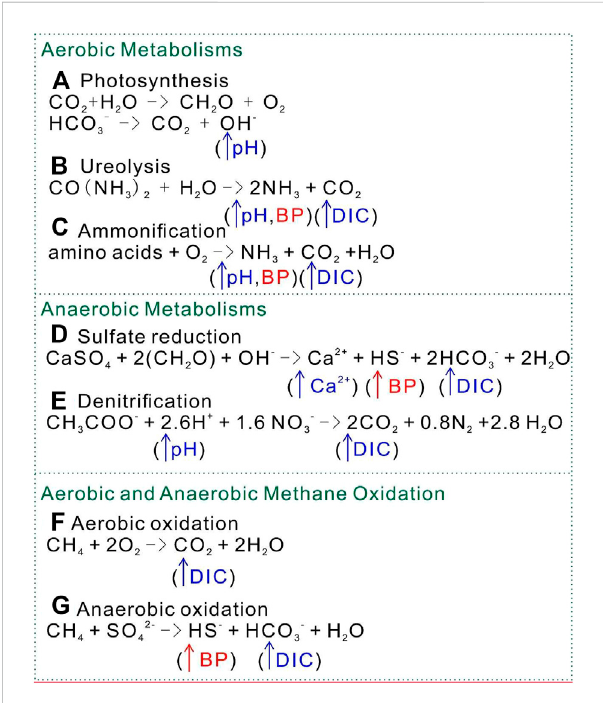
FIGURE 1 Factors that induce carbonate precipitation by different metabolisms. BP, byproduct; DIC, dissolved inorganic carbon. (A) Photosynthesis: (B) Ureolysis; (C) Ammoni fi cation; (D) Sulfate reduction; (E) Denitri fi cation; (F) Aerobic methane oxidation; (G) Anaerobic methane